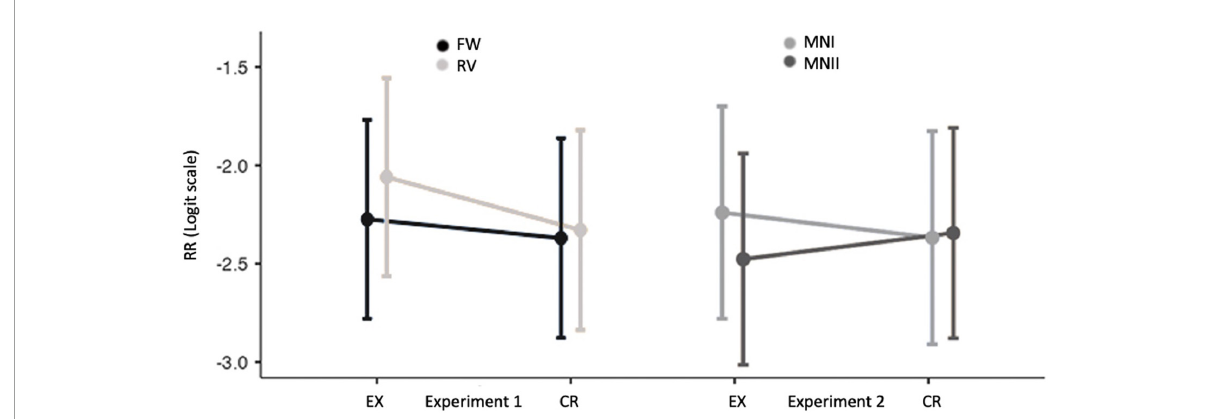
FIGURE4 Fixed effects plots: linear predictor of the rebus resolution score (RR logit scale) for the condition experimental (EX) versus control (CR) and standard error for EX and CR conditions in the FW (forward) and RV (reverse) variations of Experiment 1 and EX and CR conditions in the MNI and MNII variations MNII (with only one of the two rebus images, respectively the first and the last) of Experiment